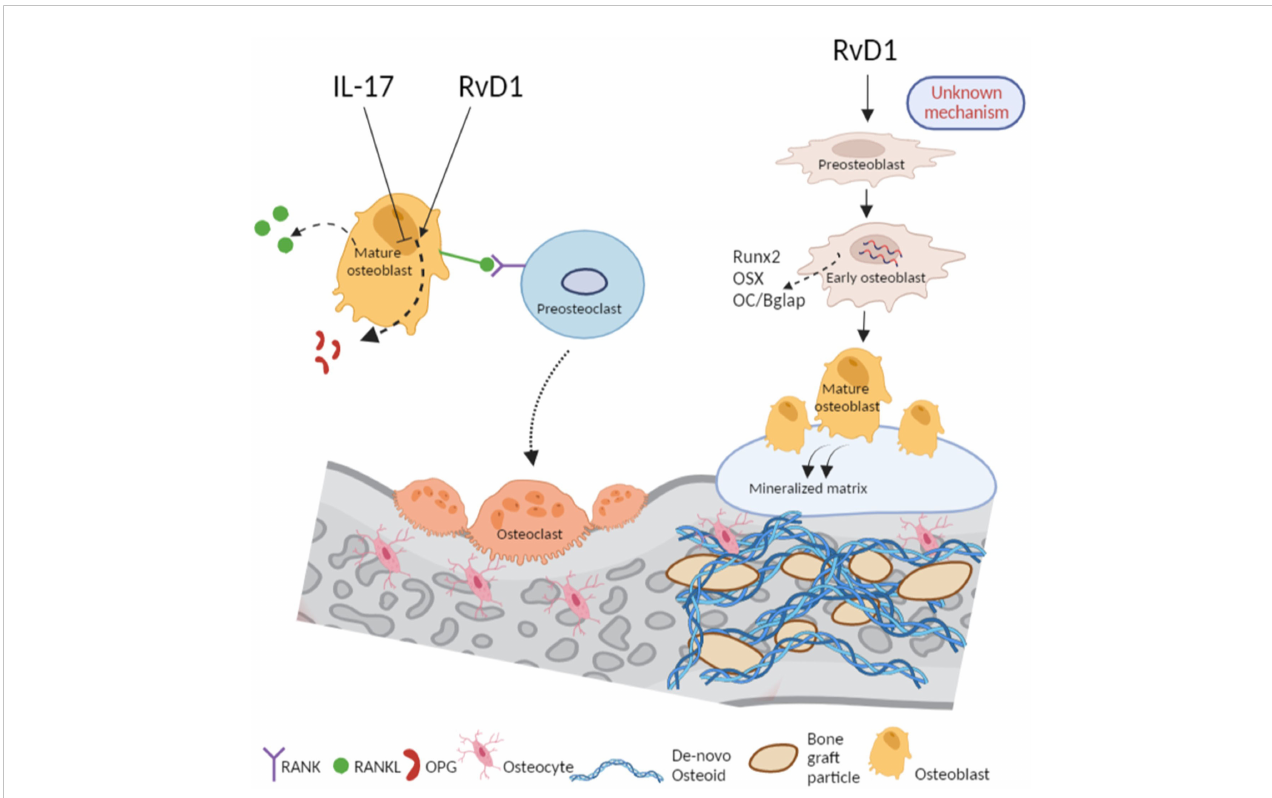
FIGURE 6 RvD1 promotes bone healing via inhibition of osteoclastogenesis and accelerating osteoblastogenesis. RvD1 controls bone healing via dual mechanisms: From left, in proin fl ammatory conditions of IL-17, the RANKL/OPG ratio is increased following a decrease of OPG thus, promoting osteoclastogenesis. In contrast, and in spite of the presence of IL-17 in the medium, RvD1 increases OPG secretion from osteoblasts, thus, leading to reduction of RANKL/OPG ratio and osteoclastogenesis inhibition. From right, RvD1 as an adjuvant in the medium of vitro cell culture of preosteoblasts directly effects them to express higher osteogenesis markers such as Runx2, OSX and OC/Bglap. Therefore, RvD1 accelerates the development of osteoblasts and their secretion of calci fi ed matrix. In vivo , RvD1 enhances the apposition of osteoid and improves bone regeneration. The fi gure was created with